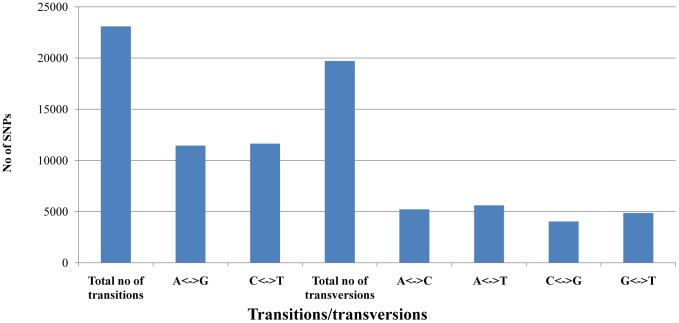
Transitions and transversions within 42,784 biallelic single nucleotide polymorphisms (SNPs) detected among jujube parents.This figure shows all the statistics of transitions and transversions SNPs between the jujube parents.